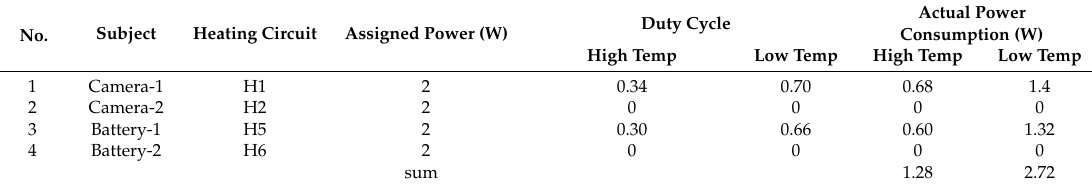
Table 14. The duty cycle and power consumption of the heating